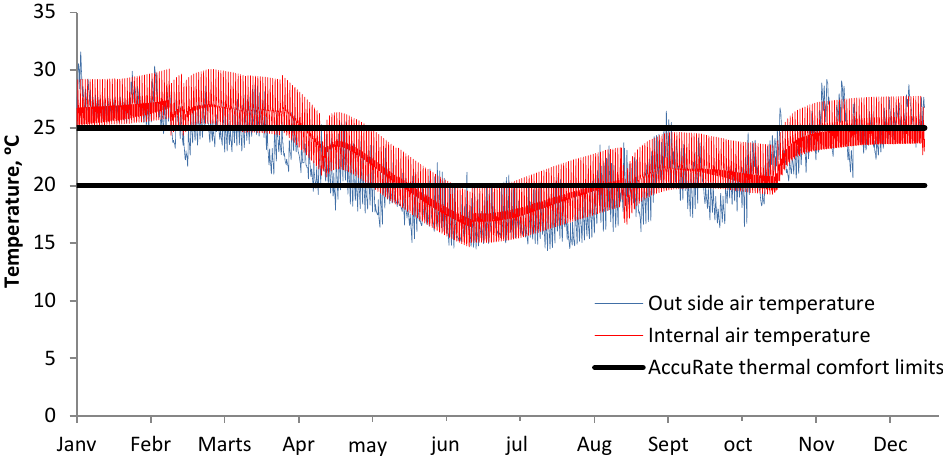
Fig. 5. Internal air temperatures and thermal comfort ranges for the InsBV module for one year.